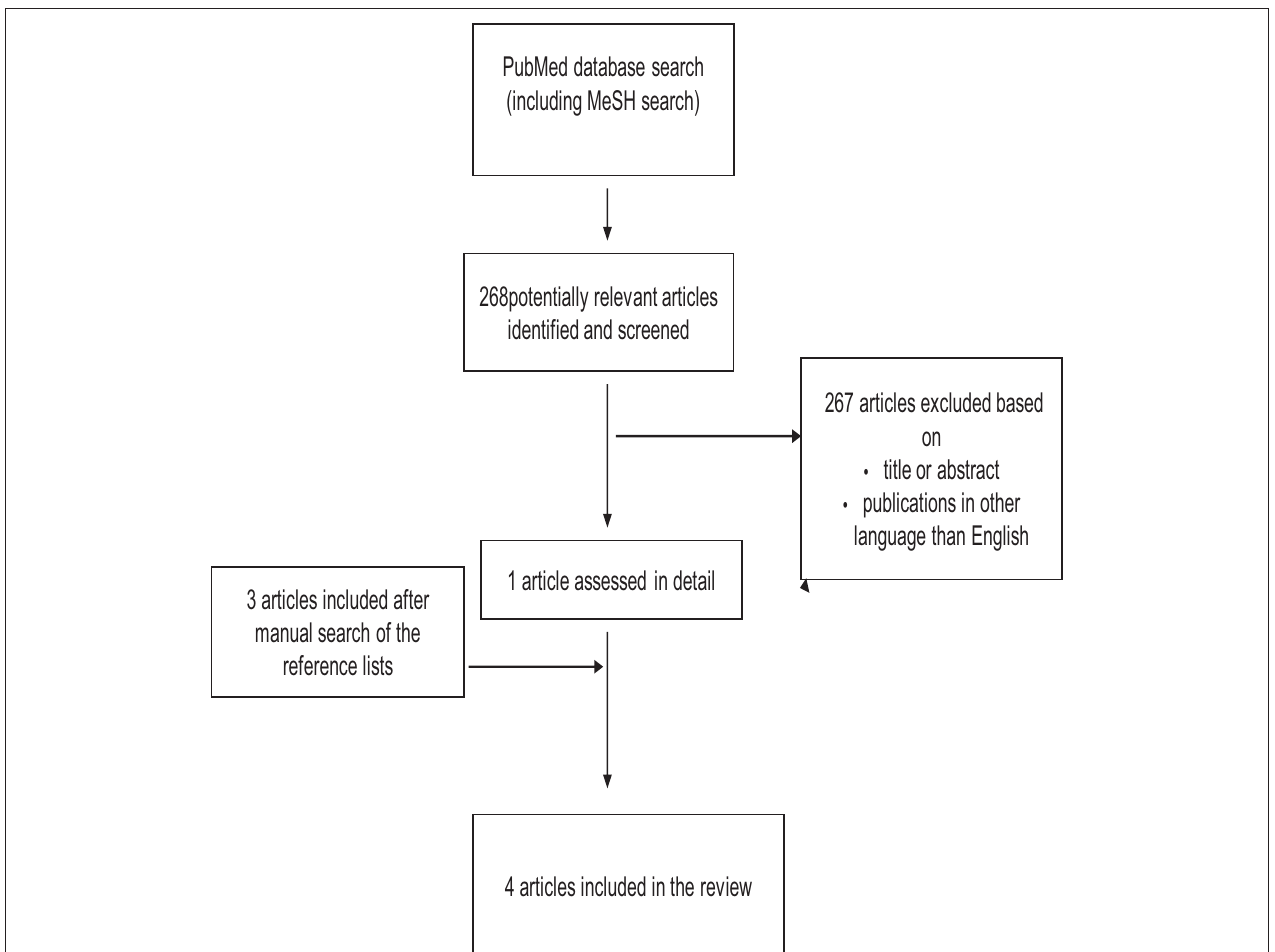
FIGURE 3 | Study selection process for articles about the association between smoking during pregnancy and cognitive and neuropsychological outcome in preterm infants.